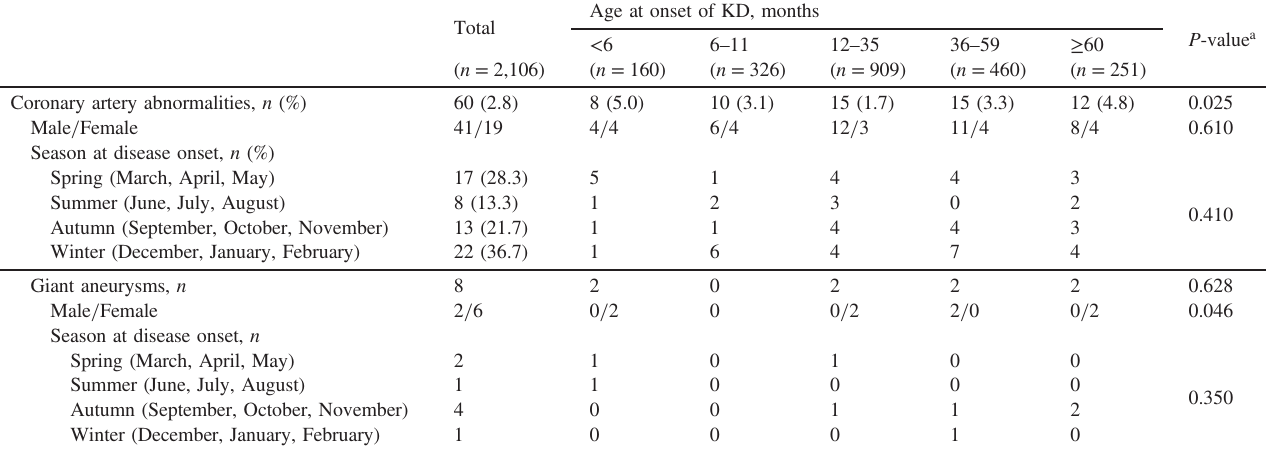
Table 2. Characteristics of patients with coronary artery abnormalities strati fi ed by age at onset of Kawasaki disease (KD) ( n =